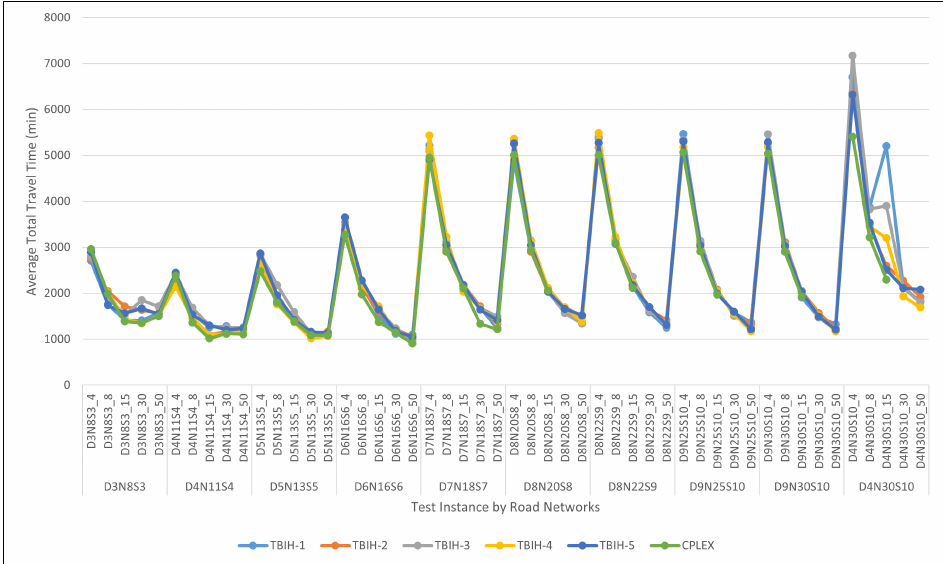
Figure A13. Algorithms performance compared to matheuristic rollout applied in PDS-RA: average total travel time (min) based on test